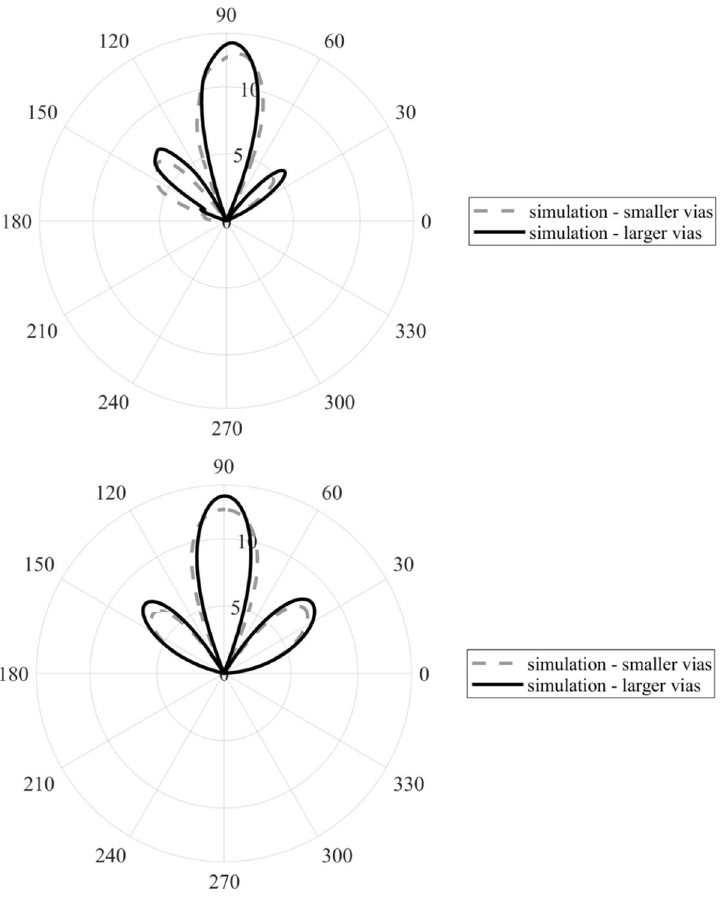
Figure 9. Comparison of the radiation patterns of the arrays with smaller and larger vias in the xy plane ( up ) and yz one ( bottom ). Shown in realized gain